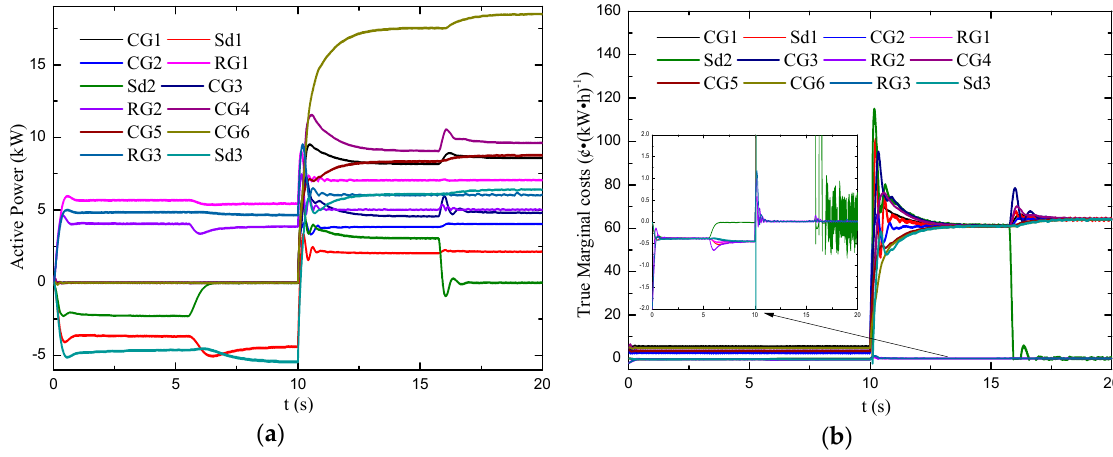
Figure 7. The results, considering storage device (Sd)2 optimization: ( a ) Active power outputs of DERs; ( b ) The true marginal costs of DERs.